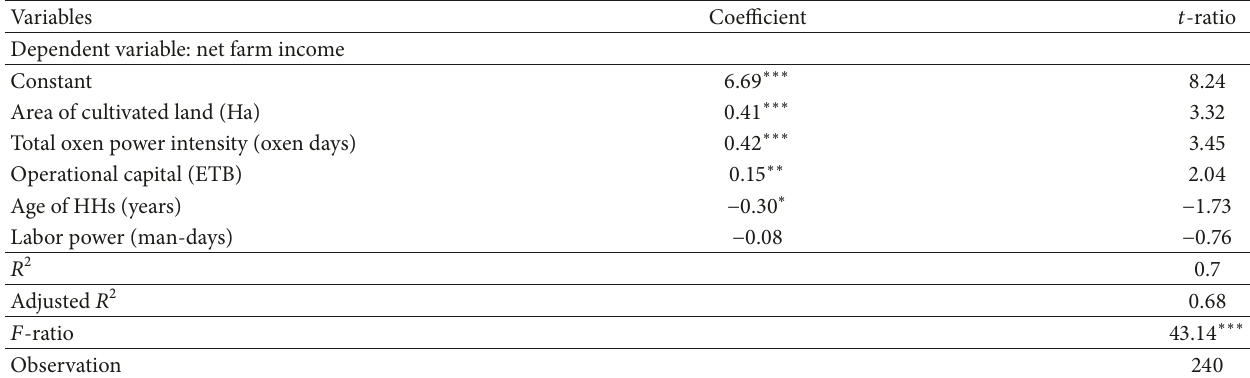
Table 2: Log transformed Cobb-Douglas production function regression